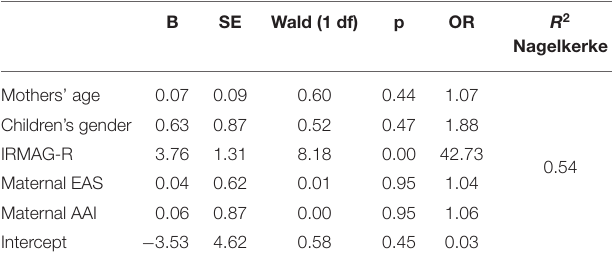
TABLE 4 | Logistic regression on maternal SSP attachment.